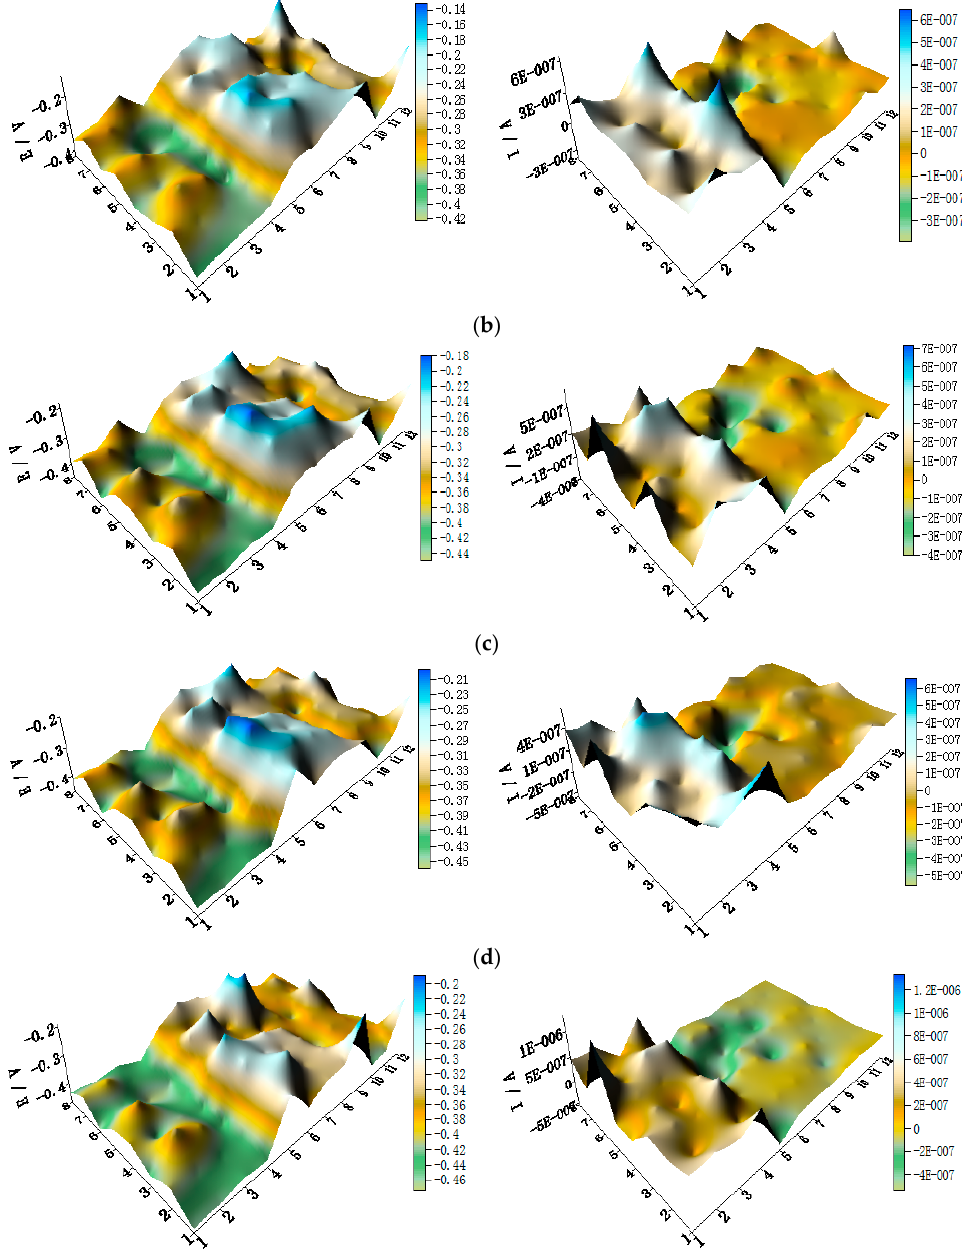
Figure 9. Spatial potential (left, E vs. SCE/V) and current–density (right, I/A) distribution maps of WBE2 after being short-circuited for 12 h in artificial seawater at different temperatures: ( a ) 30 °C; ( b ) 40 °C; ( c ) 50 °C; ( d ) 60 °C; and ( e ) 70 °C.